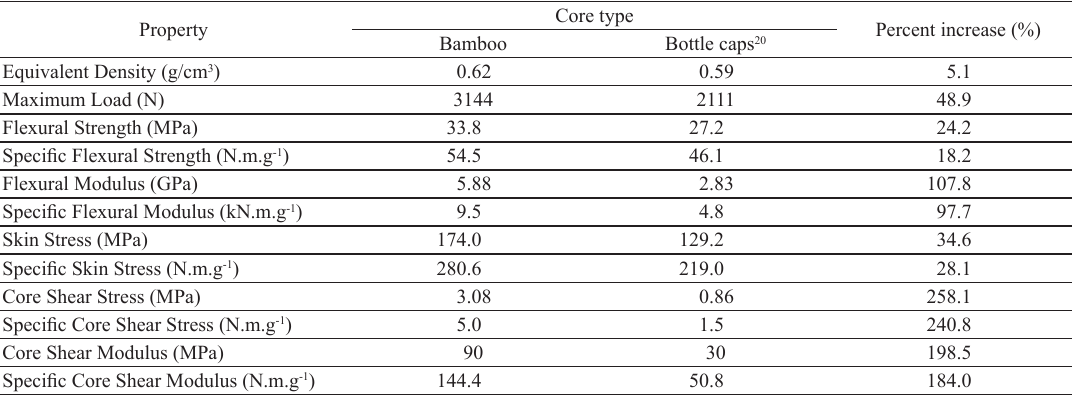
Figure 12. Second-order interaction effect plot for the core shear modulus. Figure 13. Typical bending behaviour for the sandwich panels. Table 6. Comparison between the proposed sandwich panels and bottle caps